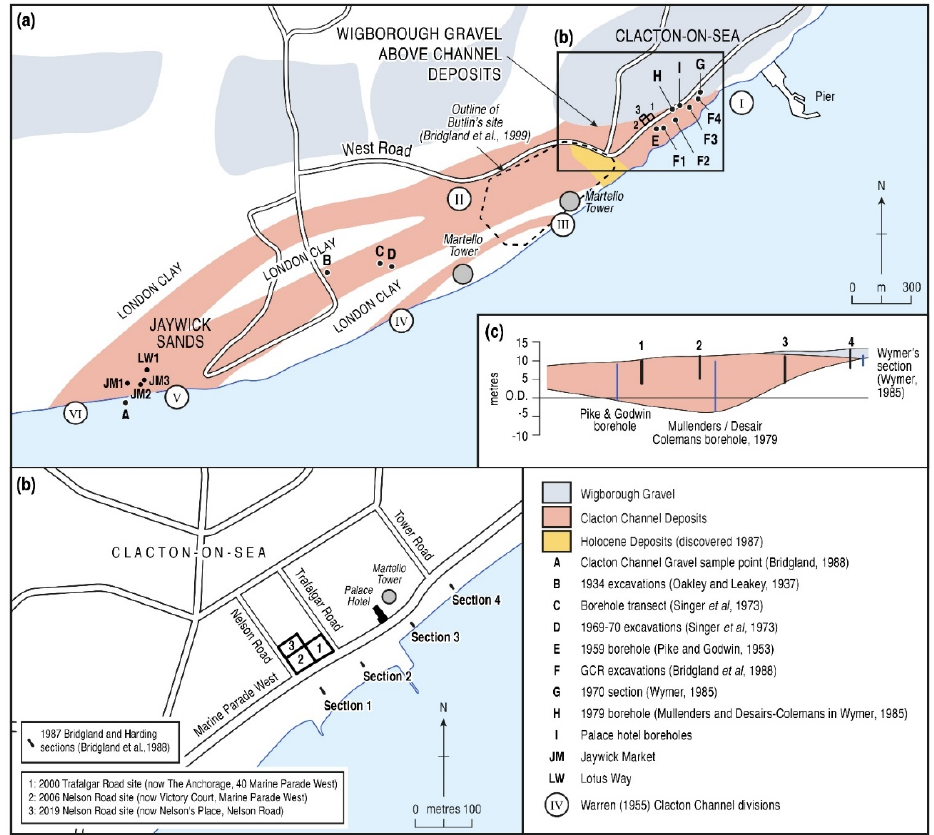
Figure 12. Quaternary sites at Clacton-on-Sea, showing the footprint of the complex of interglacial channels ( a ). Part ( b ) is an enlargement of the area around Marine Parade West, showing the locations of the recent development sites that have yielded new data and the various temporary exposures in the West Cliff during the 1980s. Part ( c ) shows the section through the channel derived from those exposures and neighbouring boreholes.